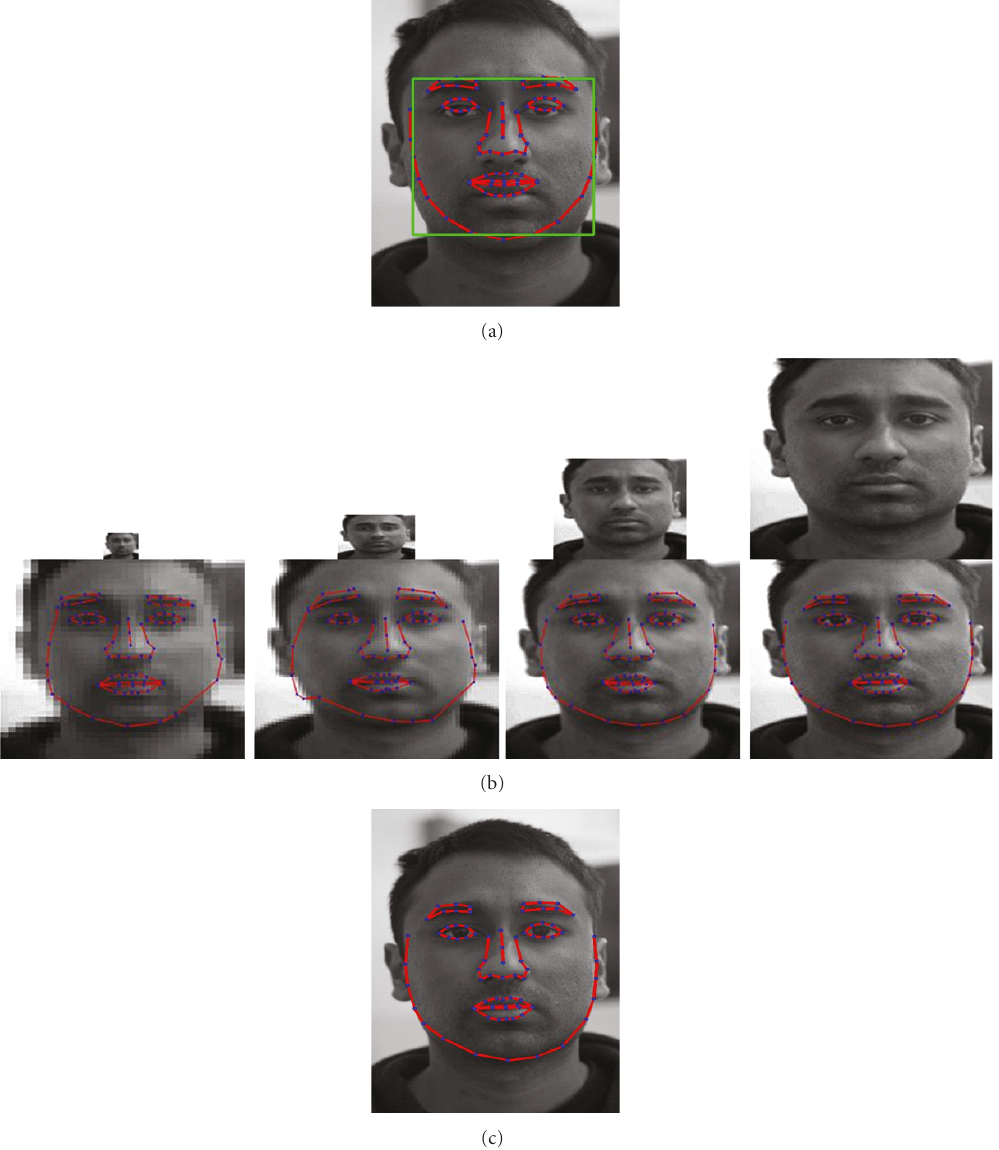
Figure 13: The mean shape fit on the output of the face detector. (b) shows the di ff erent iterations over the face at di ff erent resolutions until convergence is achieved at the highest level. This involves profiling, as well as PCA reconstruction-based (see (12)) restriction of the shape to a legal shape [30]. (c) shows the final ASM fit on the detected